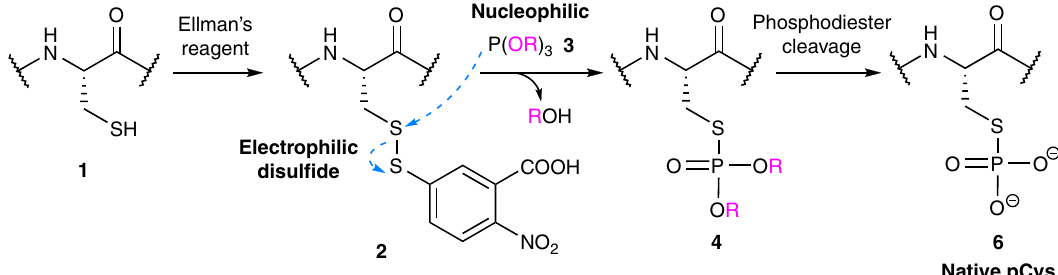
Figure 1 | Synthetic strategy to install pCys residues in unprotected peptides. Site-selective addition of phosphite to an activated Ellman-disulfide to deliver a stereochemically defined pCys